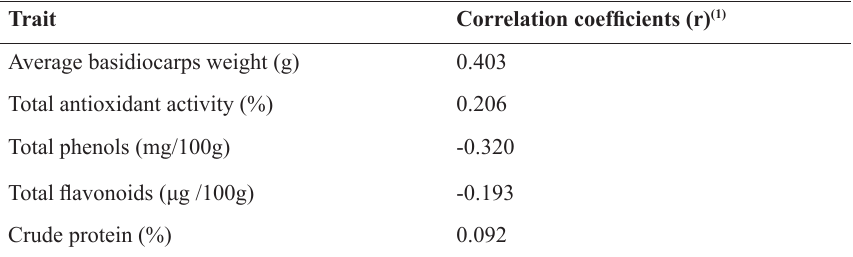
Table 3 Correlation coefficients (r) between fruiting bodies yield (g/500 g substrate) and some traits of oyster mushroom ( P. ostreatus ) produced on three sole substrates (sorghum stalks SS, banana residues BR, and rice straw RS) and six different mixtures of sorghum stalks (SS) and banana residues (BR) with rice straw (RS) at 1:1, 1:2,